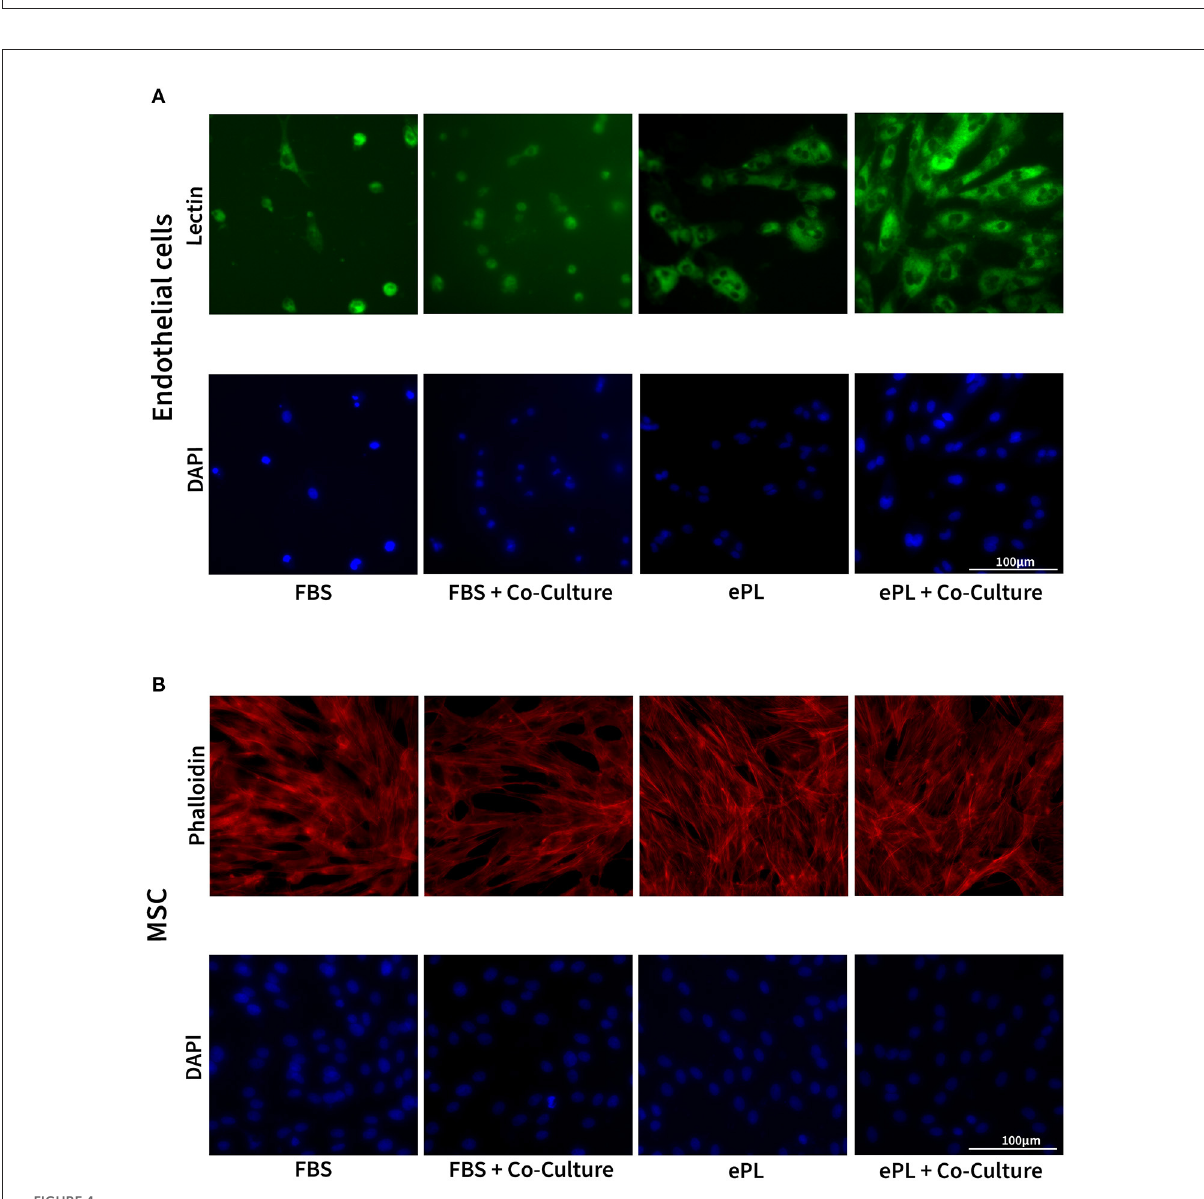
FIGURE4 Representative images of fluorescence microscopy of equine endothelial cells (A) and mesenchymal stromal cells (MSC) (B) in indirect co-culture, cultured either with 10% fetal bovine serum (FBS) and collagen matrix or with 10% equine platelet lysate (ePL) and ePL matrix. Note the different densities of endothelial cells, while MSC morphology did not appear to be different between groups.